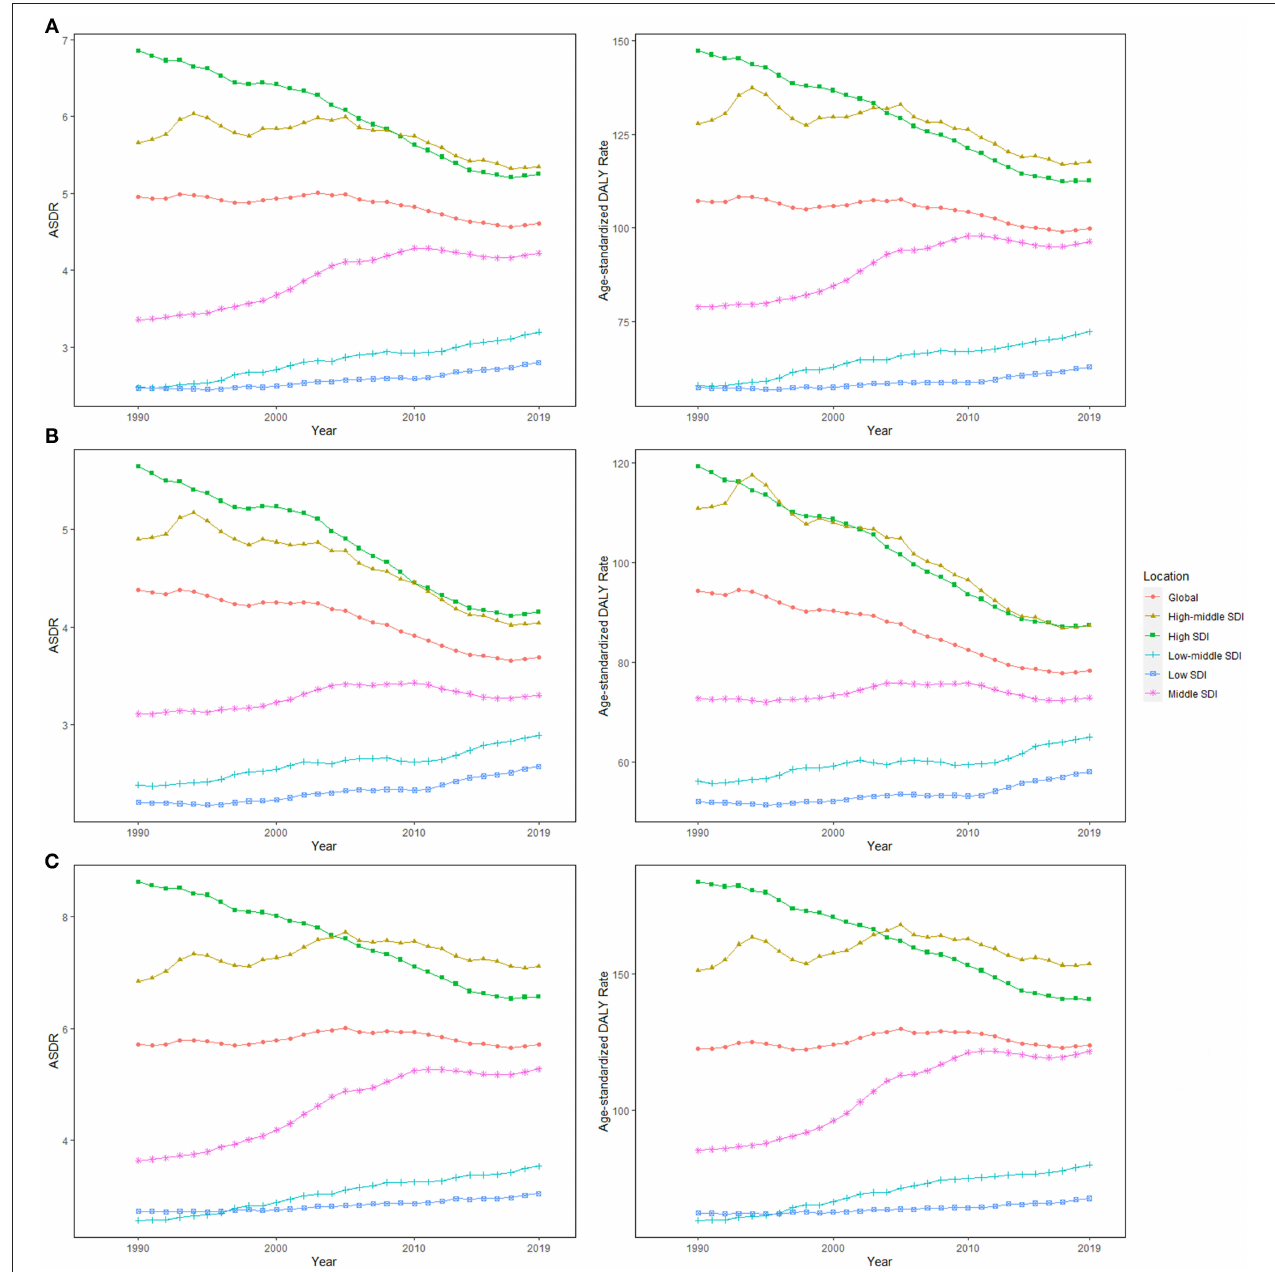
FIGURE 3 | The age-standardized rates (ASRs) for dietary risk-related colorectal cancer among socio-demographic index (SDI) quintiles over the last 30 years. (A) Both genders, (B) women, and (C) men. ASDR, age-standardized death rate; DALY, disability-adjusted life-year; SDI, socio-demographic index.